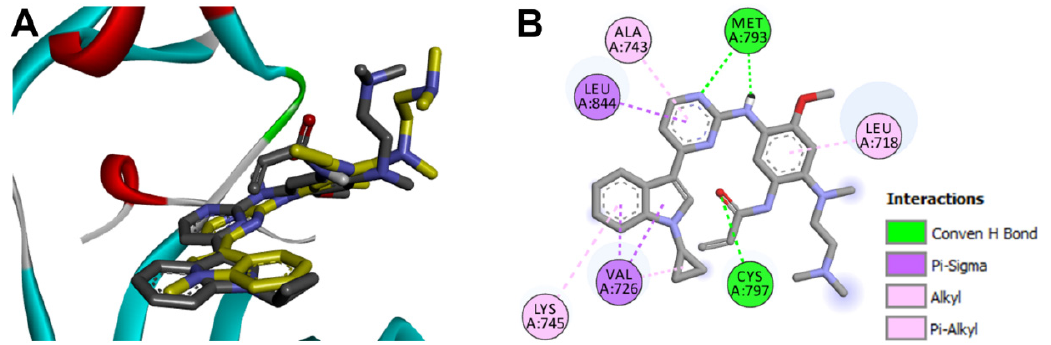
Figure 12. Binding mode/interactions of almonertinib (shown as ticks colored by element) into EGFR (pdb: 4ZAU): ( A ) 3D binding mode of the redocked almonertinib osimertinib overlaid with the co-crystallized ligand, osimertinib (shown as yellow sticks); ( B ) 2D binding mode of the redocked almonertinib showing different types of binding interactions with amino acids in the active site of EGFR.